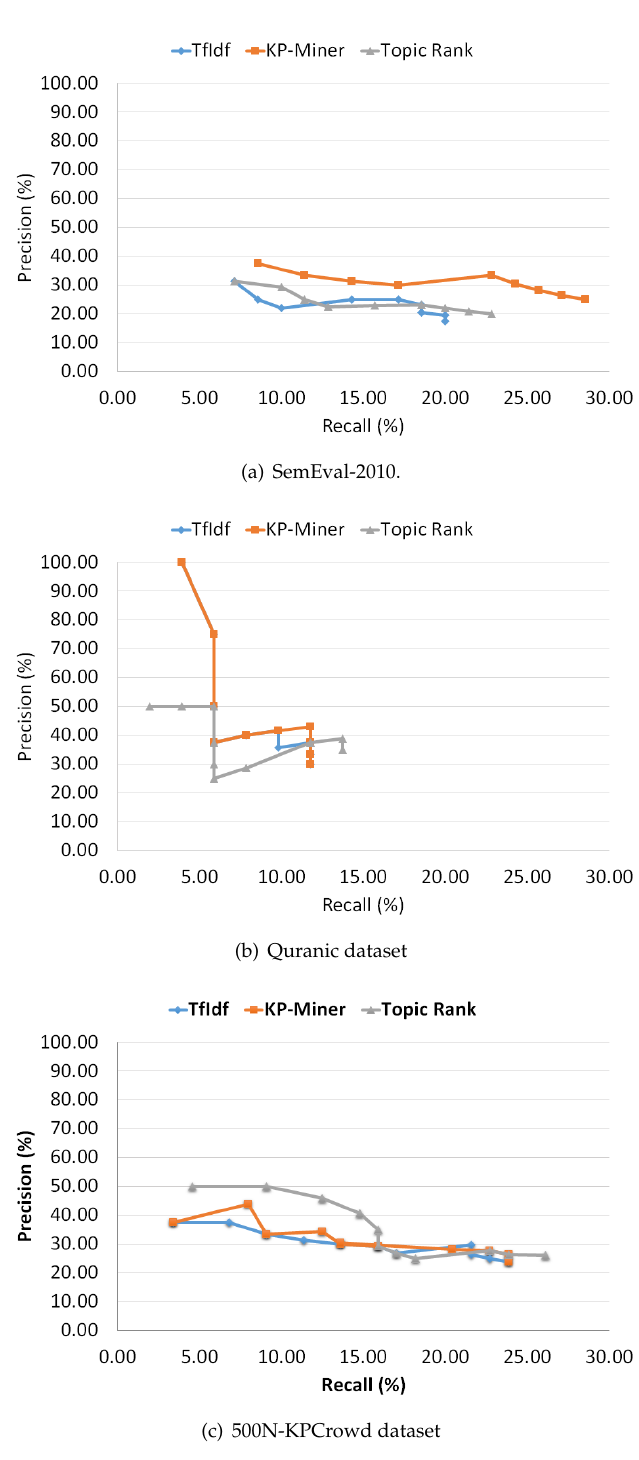
Figure 2. Precision and Recall curves for selected